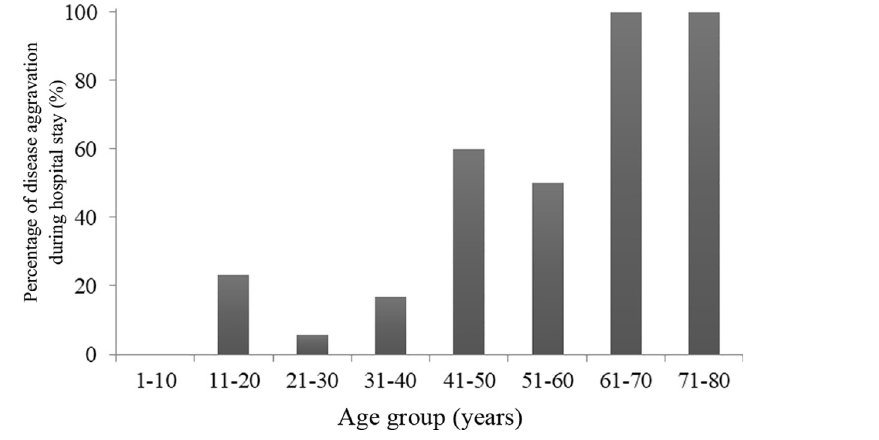
Fig 1. The percentage of COVID-19 aggravation along an age